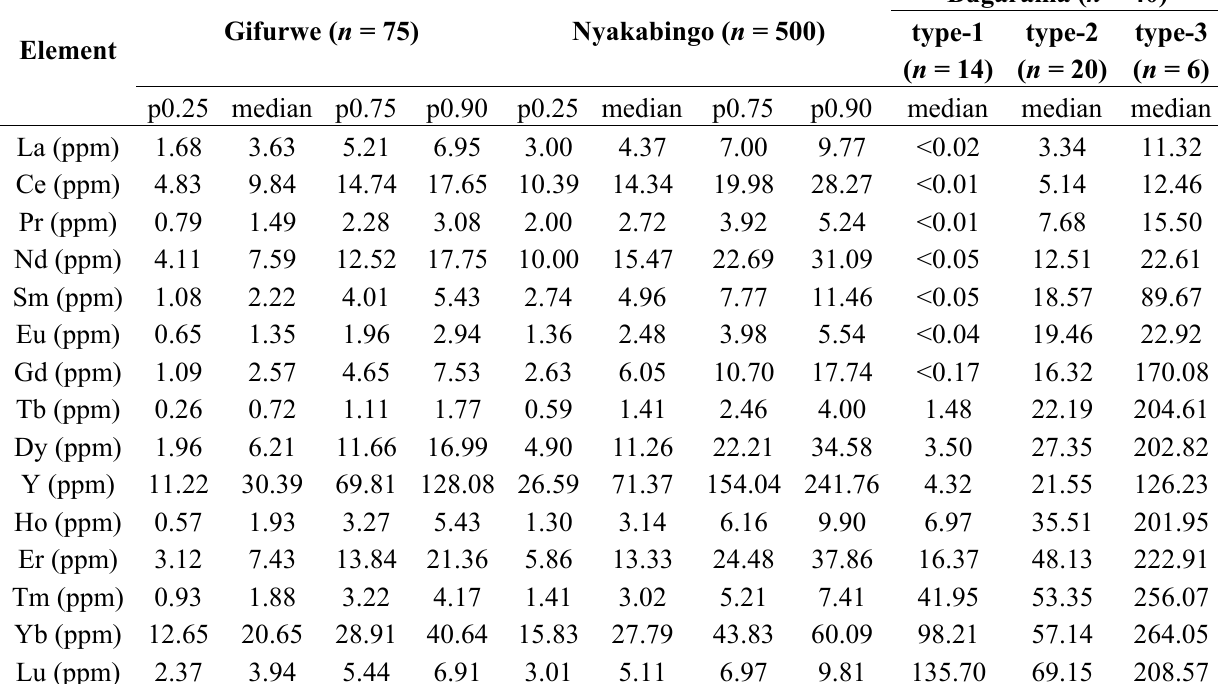
Table 2. Rare earth element composition of ferberite/reinite from the Gifurwe and Nyakabingo deposits given as the 25th percentile, median, 75th percentile and 90th percentile of 75 analyses on individual grains in ore concentrates from Gifurwe and 500 analyses on individual grains in ore concentrates from Nyakabingo. Additionally, the median values for the analyses of the different ferberite types (type-1, type-2, type-3) from two polished sections (polished sections 1 and 2) from the Bugarama deposit are also given. If values are below the detection limit, the detection limit are given as the 80th percentile of all detection limits from the individual analysis per single